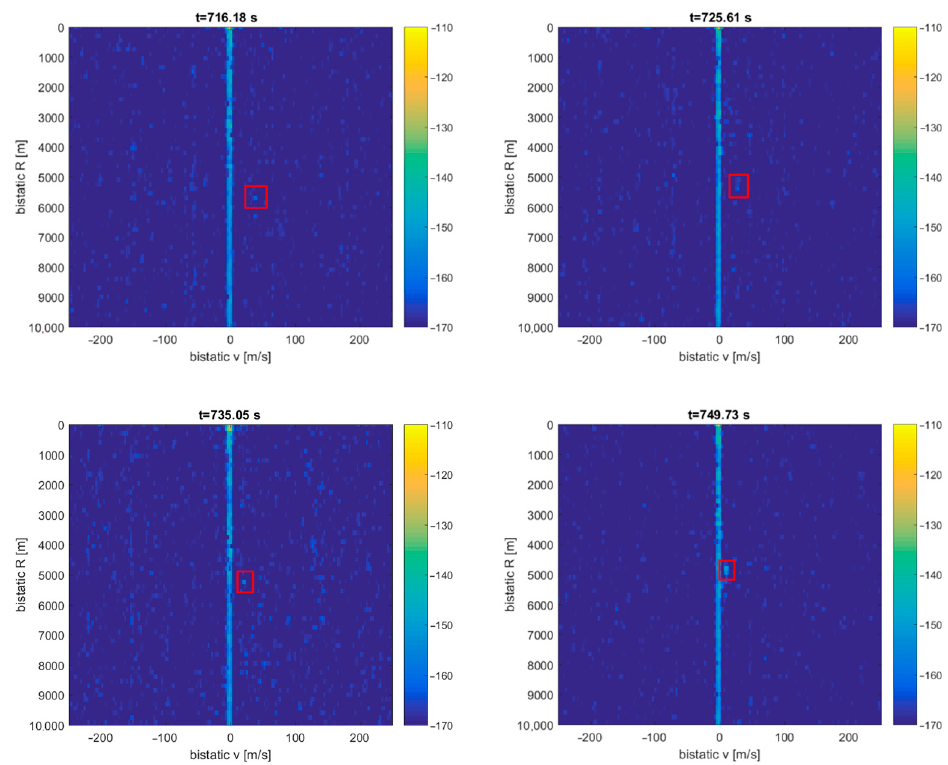
Figure 28. LOT4CG detection visible with integration time increased to 524 ms (scene in Figure 26).